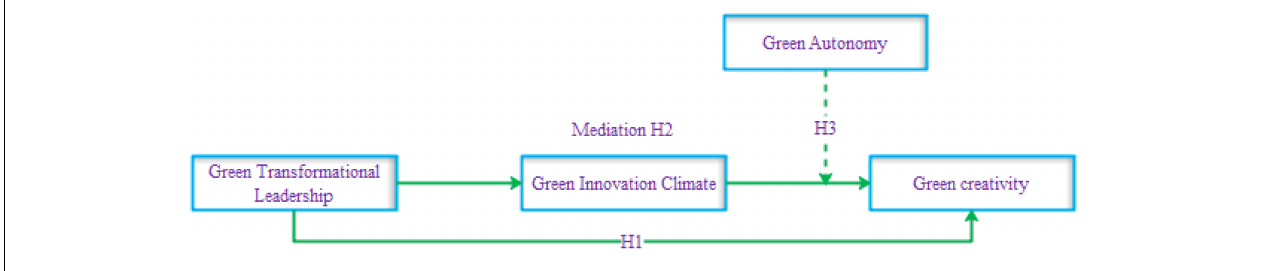
FIGURE 1 | Conceptual